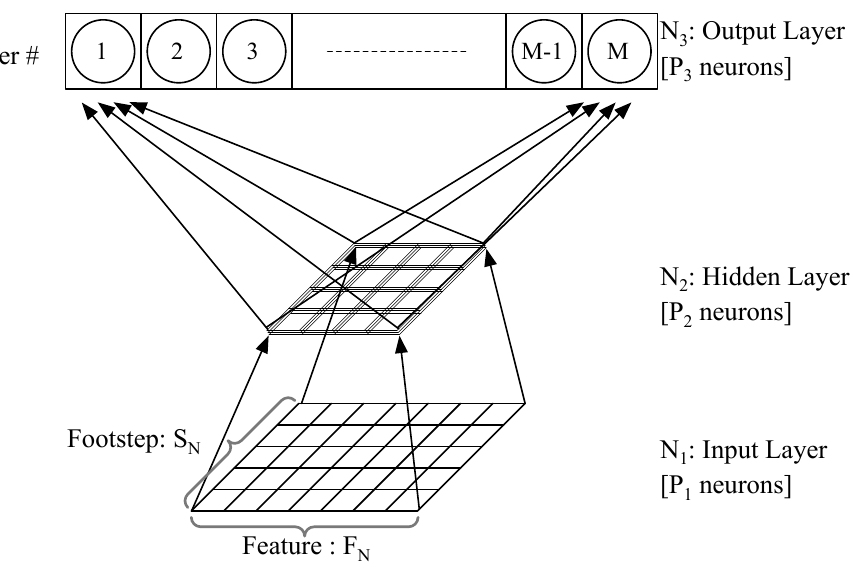
Figure 11. Structure of the neural network for user